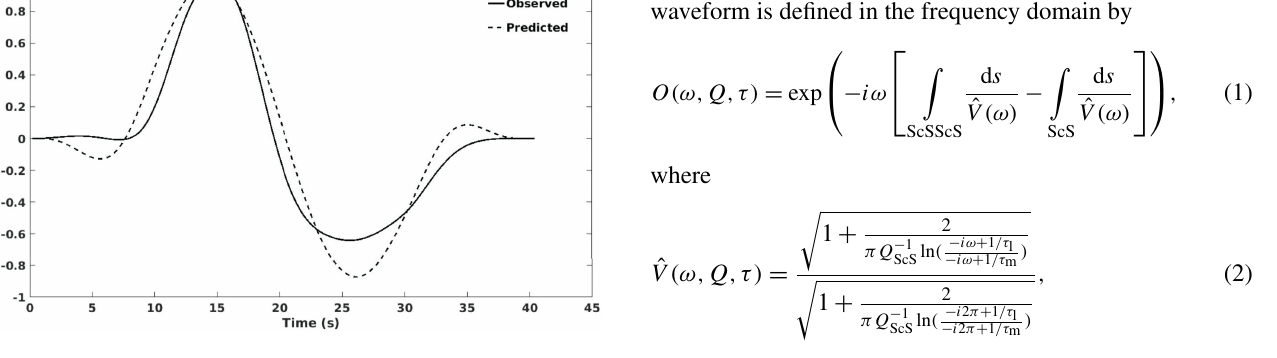
Figure 4. Observed and predicted ScSScS velocity waveform aligned by the arrival time of first extremum and normalized by the peak-to-trough amplitude. The least squares norm difference be- tween these two waveforms is obtained using a summation of am- plitude differences over